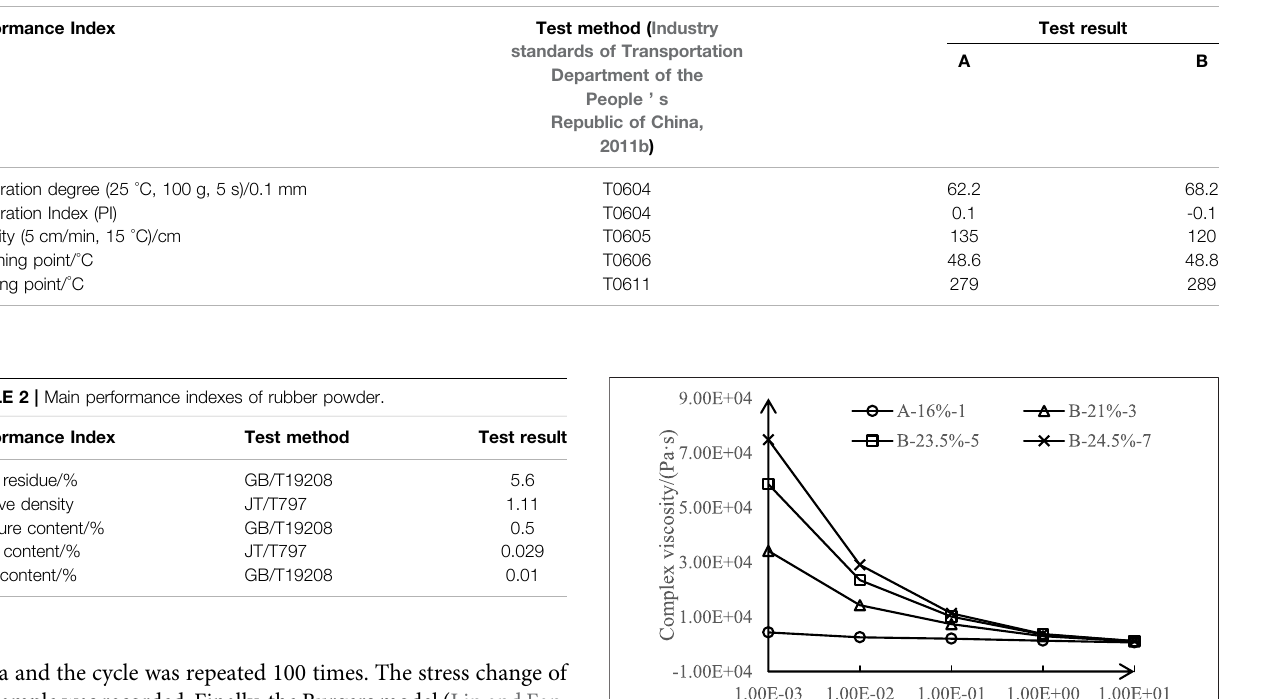
TABLE 1 | Main performance indexes of matrix asphalt.